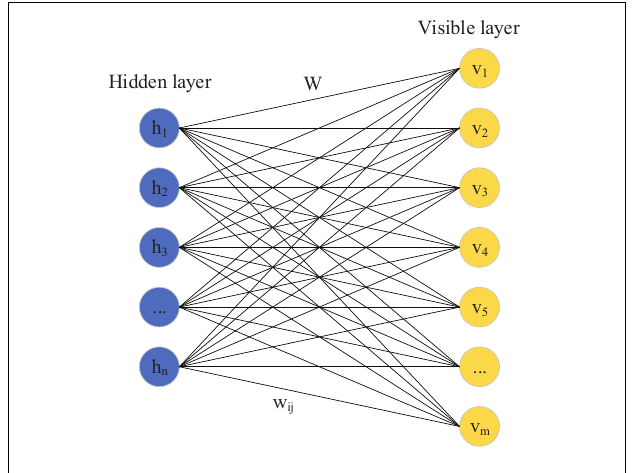
FIGURE 1 | Structure of